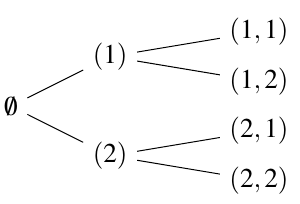
Figure 8: The tree T 2 for d = 2.